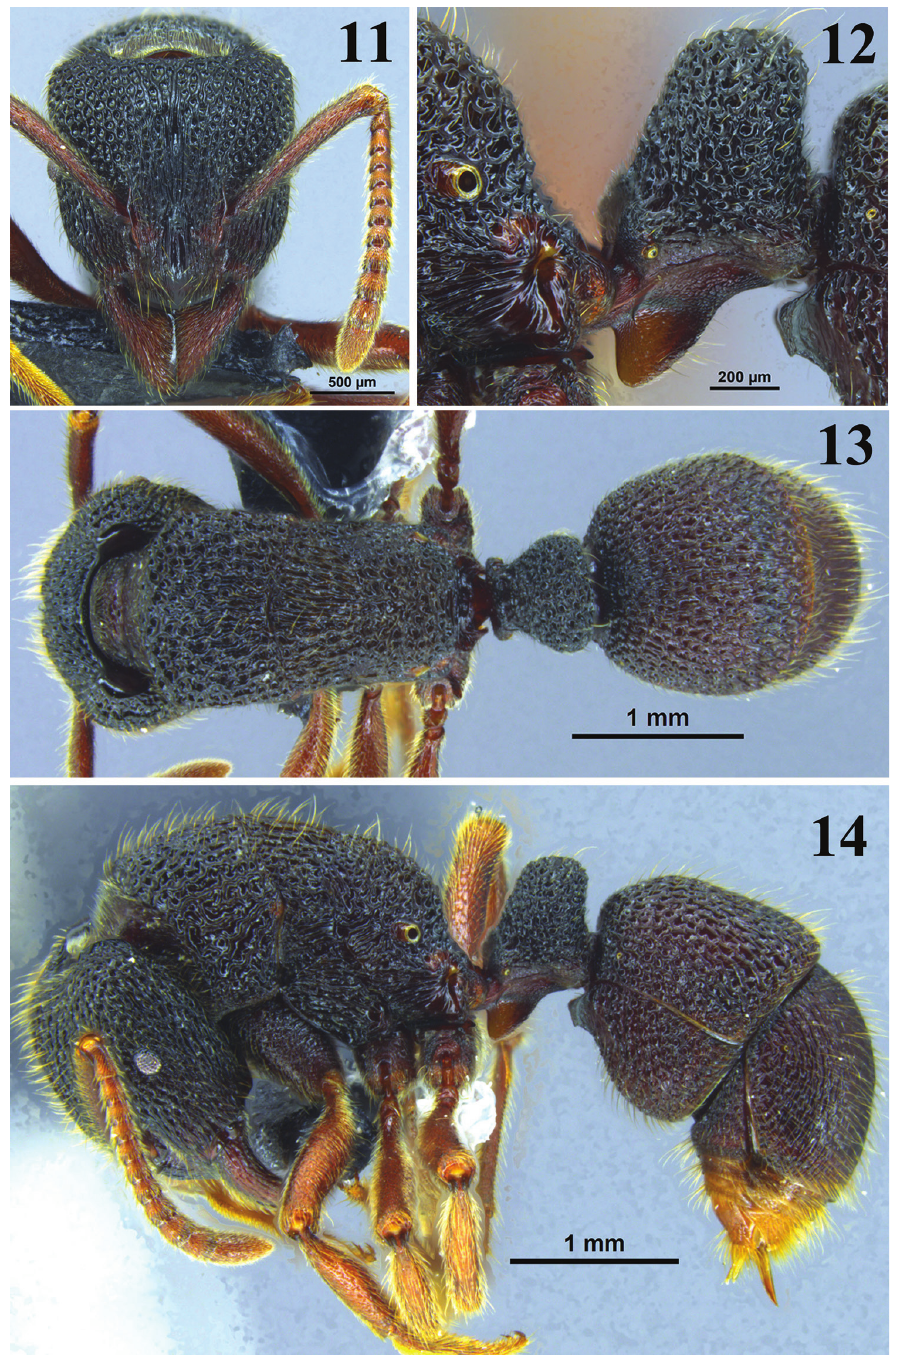
Figures 11−14. Gnamptogenys nanlingensis holotype worker (No. G150025). 11 head in full-face view 12 petiole in lateral view 13 body in dorsal view 14 body in lateral